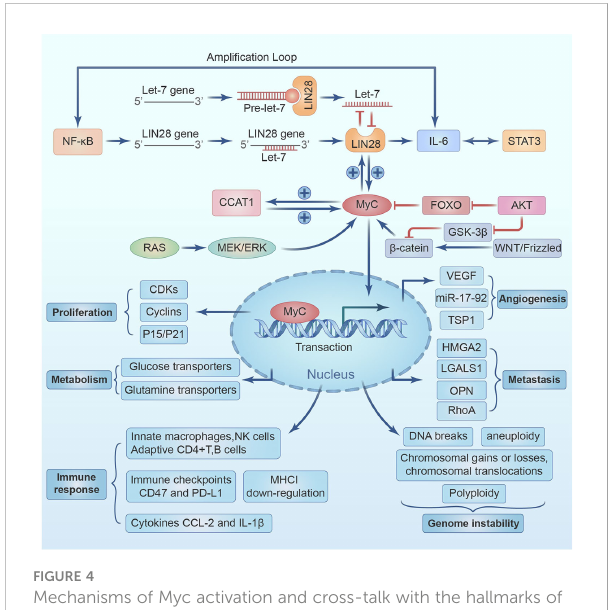
FIGURE 4 Mechanisms of Myc activation and cross-talk with the hallmarks of